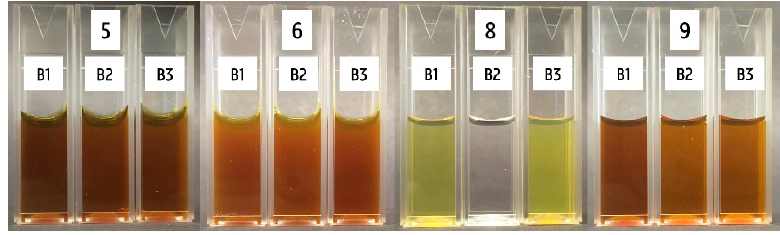
Figure 3. Visual analysis of the three different production batches of products 5, 6, 8, and 9.